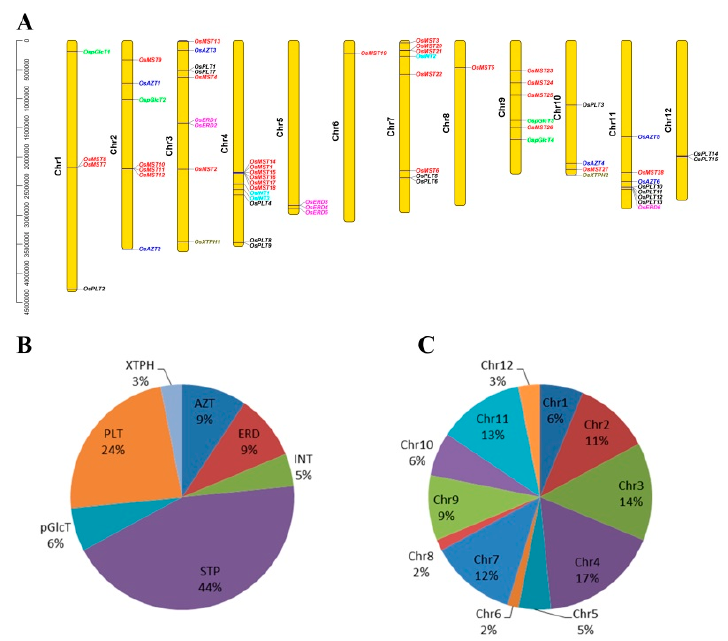
Figure 2. Chromosomal locations of the monosaccharide transporter (MST) genes. ( A ) Different colors of genes represent the members from different subfamilies. ( B ) Pie charts of different sizes indicate the ratio of each subfamily. ( C ) Pie charts of different sizes indicate the ratio of each chromosome.